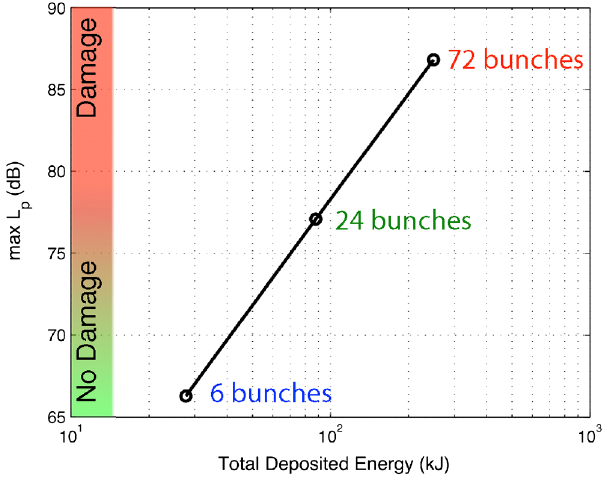
FIG. 12. Sound pressure level for microphone 1 vs the total deposited energy for test cases listed in Table V. Linear interpolation yields a reference curve which can be used to estimate the damage extent from the sound pressure level for the given setup and beam parameters.